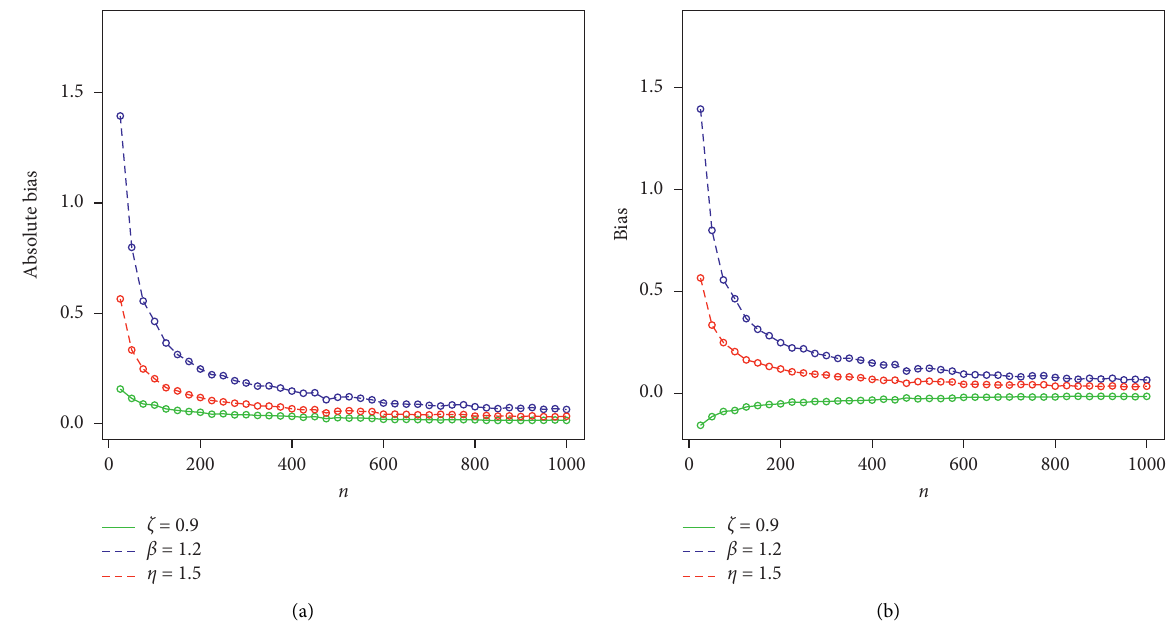
Figure 7: Graphical display of the simulation results provided in Table 1. (a) Plot of absolute blases vs. n. (b) Plot of blases vs. n.